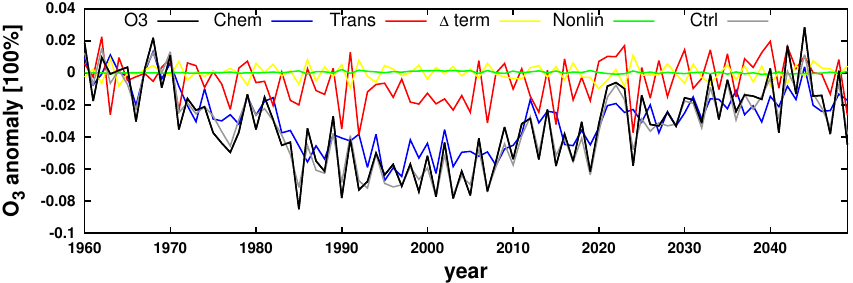
Fig. 2. Demonstration of ozone attribution method: time series of zonal mean lower stratospheric partial column ozone at 45 ◦ S relative to the mean 1960–1969 (black solid line) as simulated by E39CA, together with changes induced by transport (red), changes induced by chemistry (blue), the imbalance term (yellow), the nonlinear term (green) and the sum of these four terms (control line, grey).